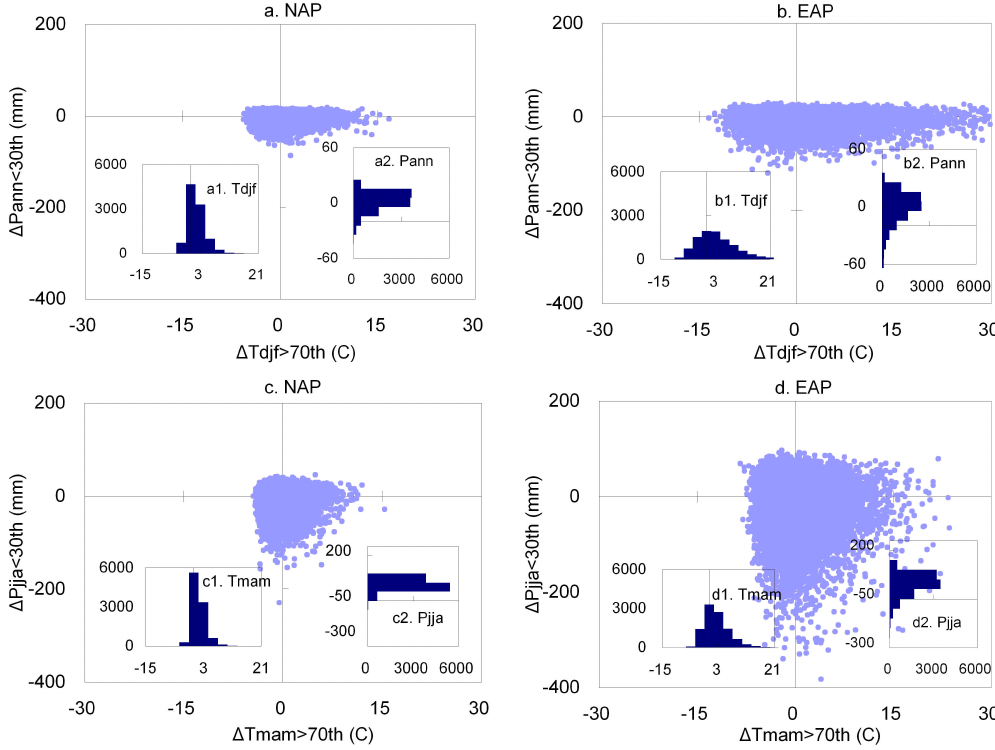
Fig. 4. 2-D scatter diagrams of Gumbel distribution climate extremes in the NAP (a, c) and EAP (b, d) . Combinations 1T djf > 70th and 1P ann < 30th percentiles (a, b) and 1T mam > 70th and 1P jja < 30th percentiles (c, d) respectively. Frequency diagrams (insert panels – a1, a2, b1, b2, c1, c2, d1 and d2) are plotted for 10000 samples of 1T (along x-axis, units in degrees Celsius) and 1P (along y-axis, units in mm). All climate variable abbreviations are the same as in the